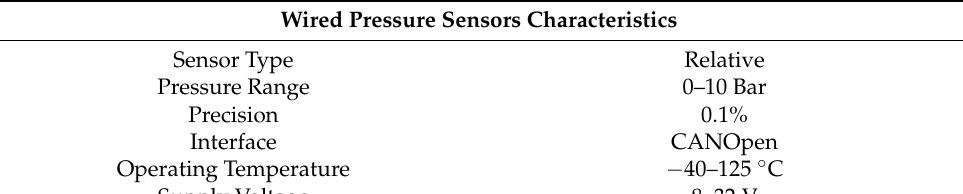
Figure 6. Mercitalia Intermodal T3000e freight wagon.